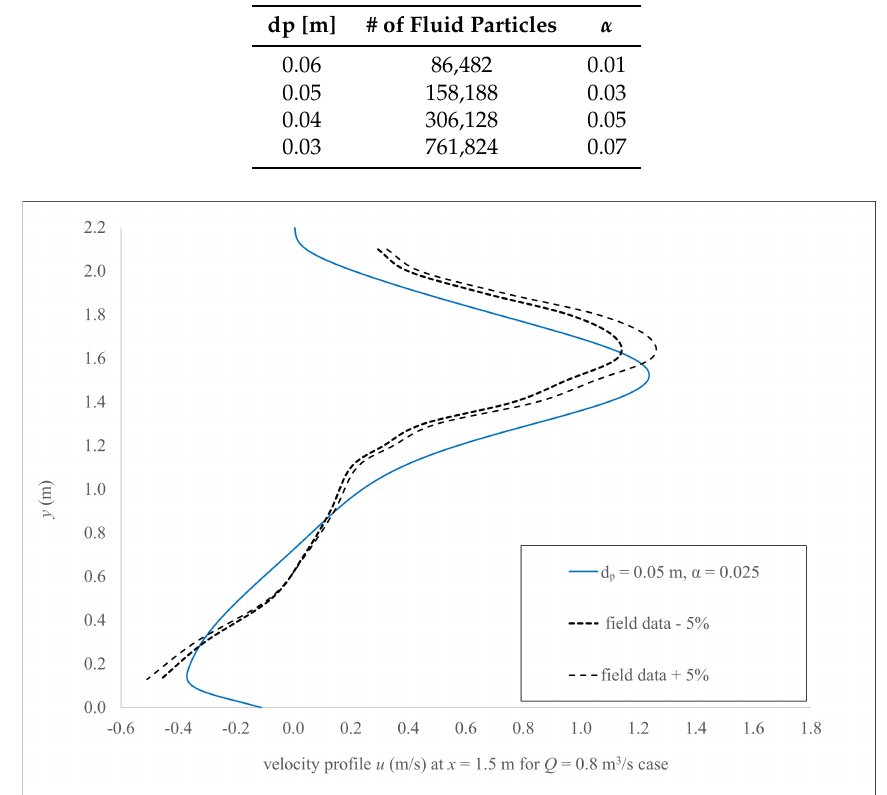
Table 4. Relation between particle spacing, dp , number of fluid particles, and viscosity coefficient, α .